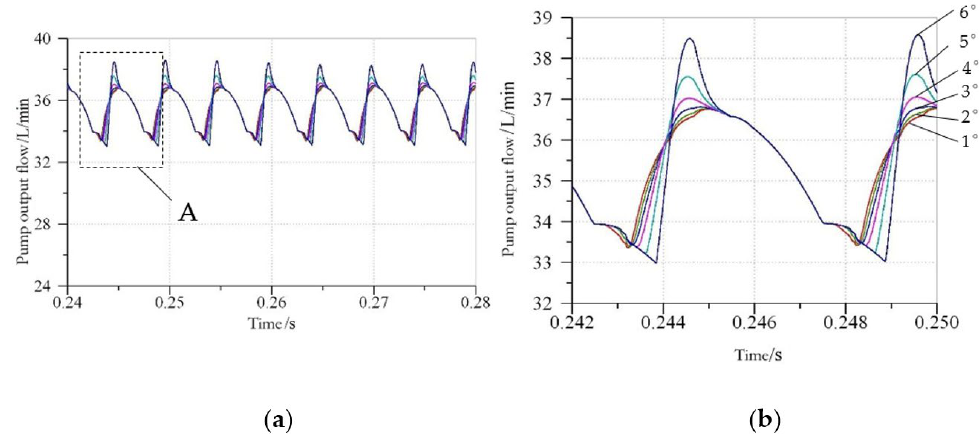
Figure 15. Actual output flow rate of piston pump with 8 pistons for ∆ ϕ /2 = ϕ 0 = 1~6 ◦ . ( a ) Pump output flow; ( b ) Pump output flow (enlarged view at A).